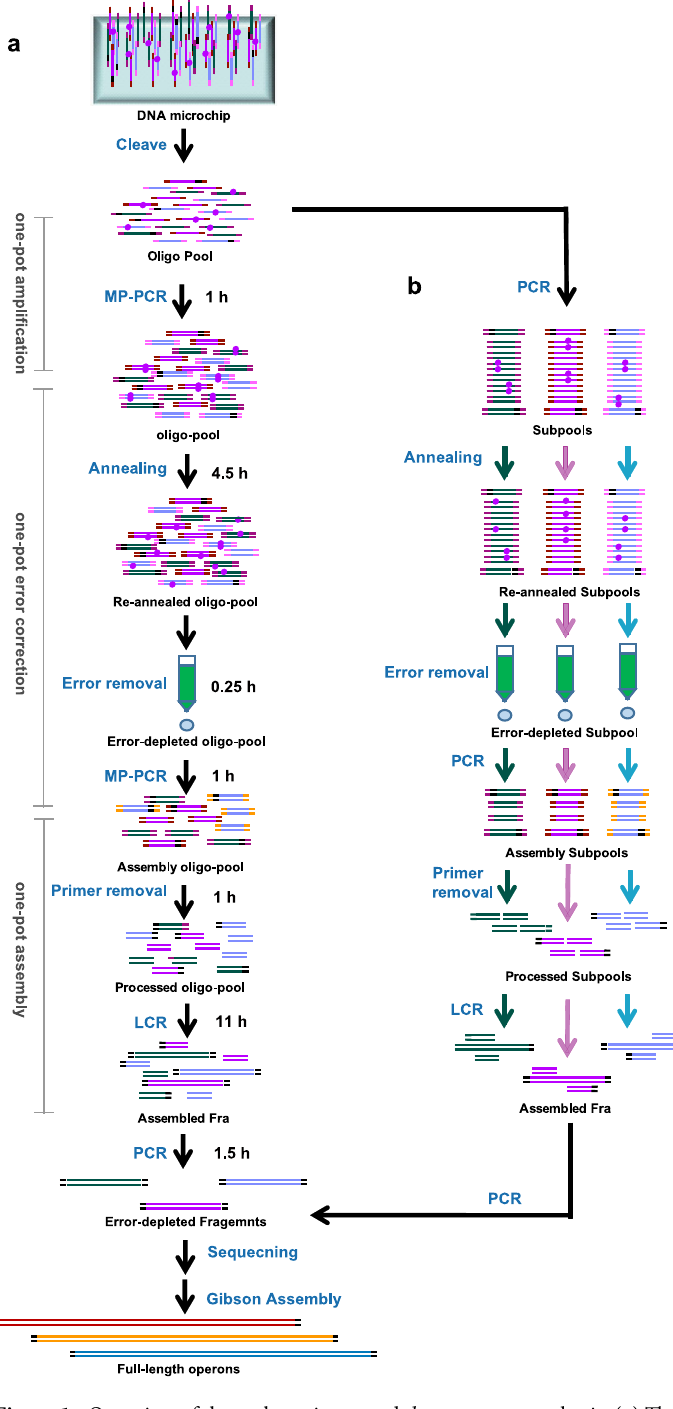
Figure 1. Overview of throughput-improved de novo gene synthesis. ( a ) Throughput-improved DNA synthesis strategy, in which the throughputs of oligo amplification, error-removal and assembly were improved to 479 unique oligos. ( b ) Low-throughput DNA synthesis strategy developed in our previous